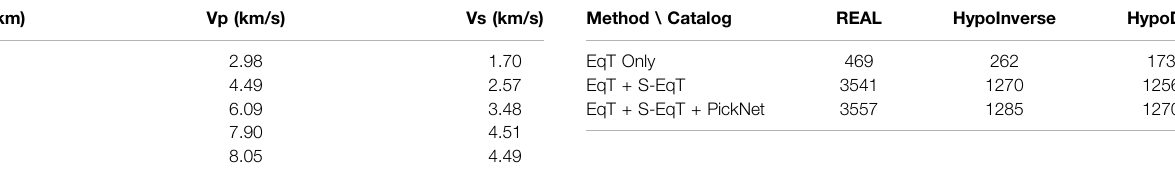
TABLE 1 | Layered 1-D velocity model used in this study. The velocity corresponds to the value at the top of each layer. Depth (km) Vp (km/s) Vs (km/s) 0.00